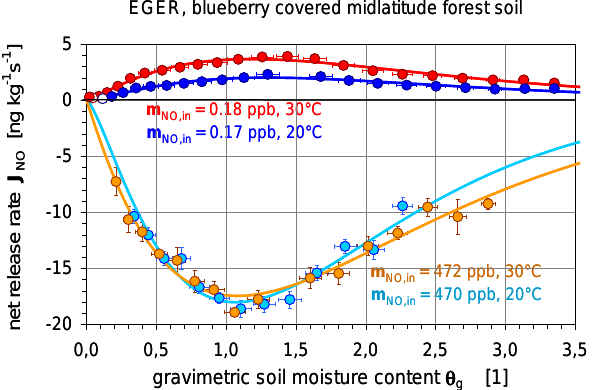
Figure 14. As Fig. 10, but for a sample taken from a hyper-arid Fig. 14: as Fig. 10, but for a sample taken from a hyper-arid soil in the Gobi desert, soil in the Gobi desert, Mongolia. Data points originated from two Mongolia. Data points originated from two replicate measurements (two replicate measurements (two different sub-samples) which are iden- different sub-samples) which are identified by corresponding circles and tified by corresponding circles and diamonds. Data points marked diamonds. Data points marked by empty circles and diamonds fall within the by empty circles and diamonds fall within the “deadband” of non- “deadband” of non-detectable values (defined by ± minimum detectable net NO detectable values (defined by ± minimum detectable net NO release release rate).